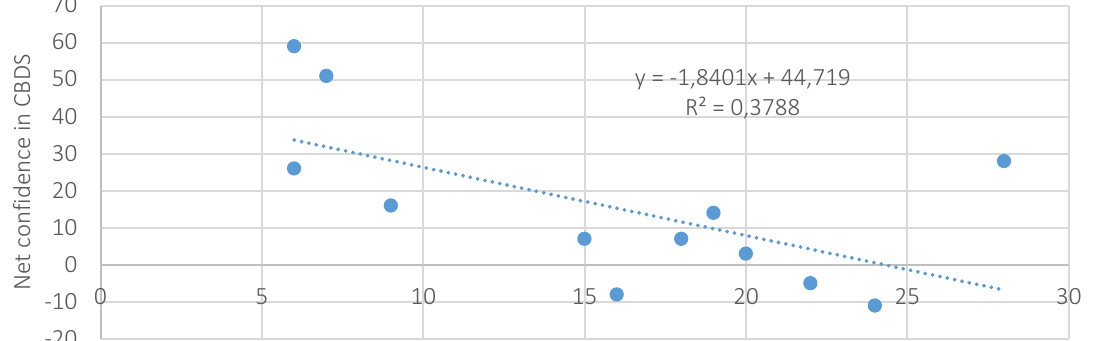
y = -1,8401x + 44,719 R² = 0,3788